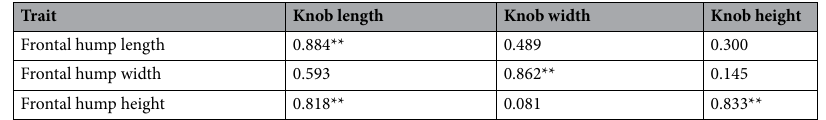
Table 1. Correlation coefficients between knob and frontal hump dimensions. Significant differences are indicated with two asterisks ( P < 0.01).